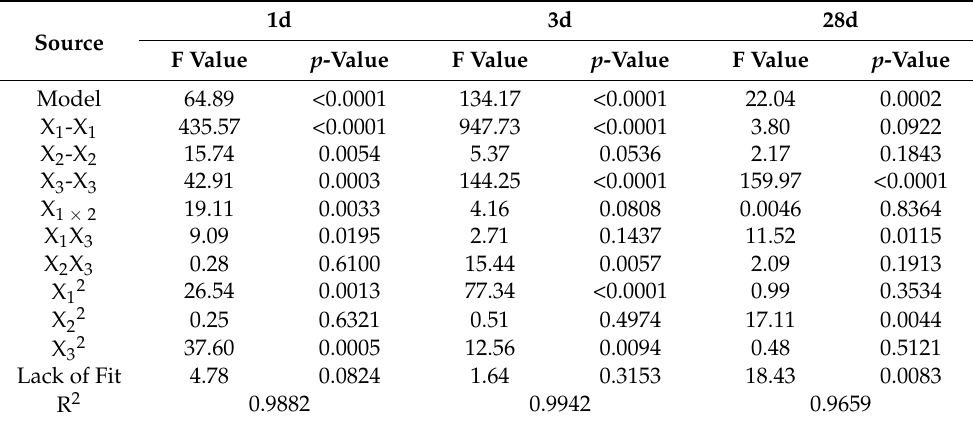
Table 7. Analysis of variance of response surface